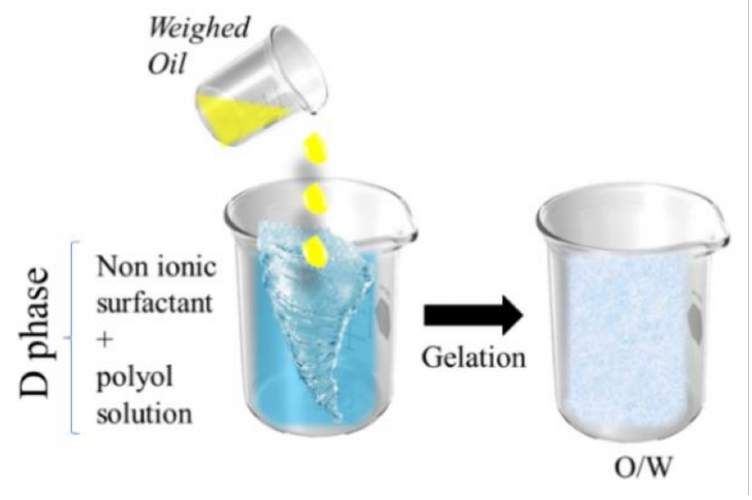
Figure 5. Illustration of D-phase emulsification. This is a self-drawn